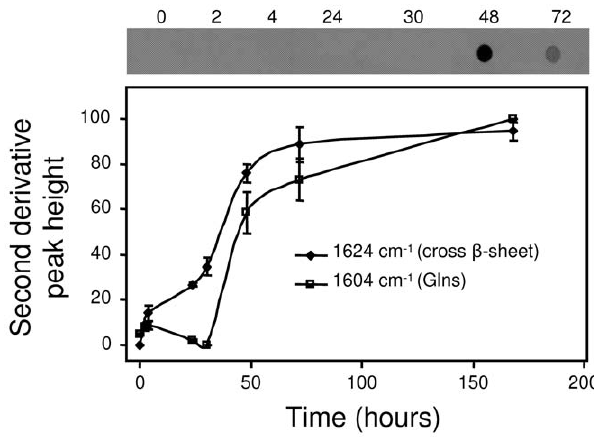
Figure 5. Time course of AT3Q55 aggregation upon incubation at 37 6 C in PBS. Aggregation was monitored by detecting either the appearance of SDS-insoluble aggregates by filter trap assays (upper panel), or cross b -sheet (1625 cm 2 1 ) and glutamine side chain bands (1604 cm 2 1 ) (lower panel). The band heights from the second derivative spectra (normalized at the tyrosine peak to allow for possible differences in protein content) are reported as percentage variations in the time span 0–168 h. Standard deviations from three independent experiments are indicated.